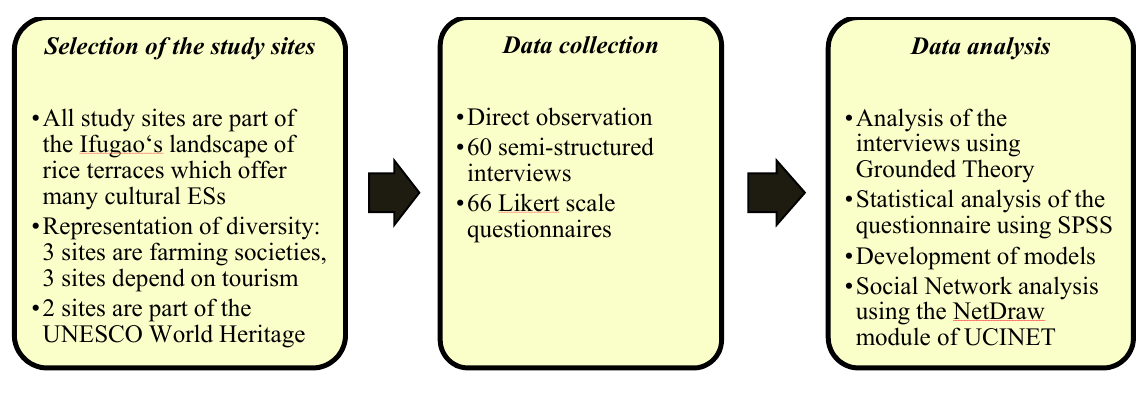
Figure 3. Main steps of the methodological process (Source: own